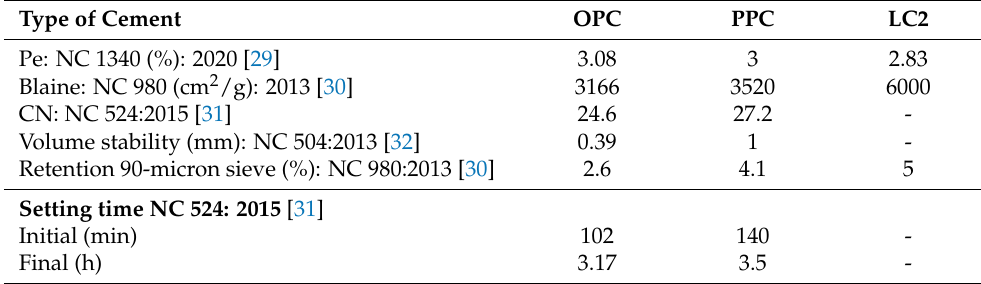
Table 1. Main characteristics of the cements and